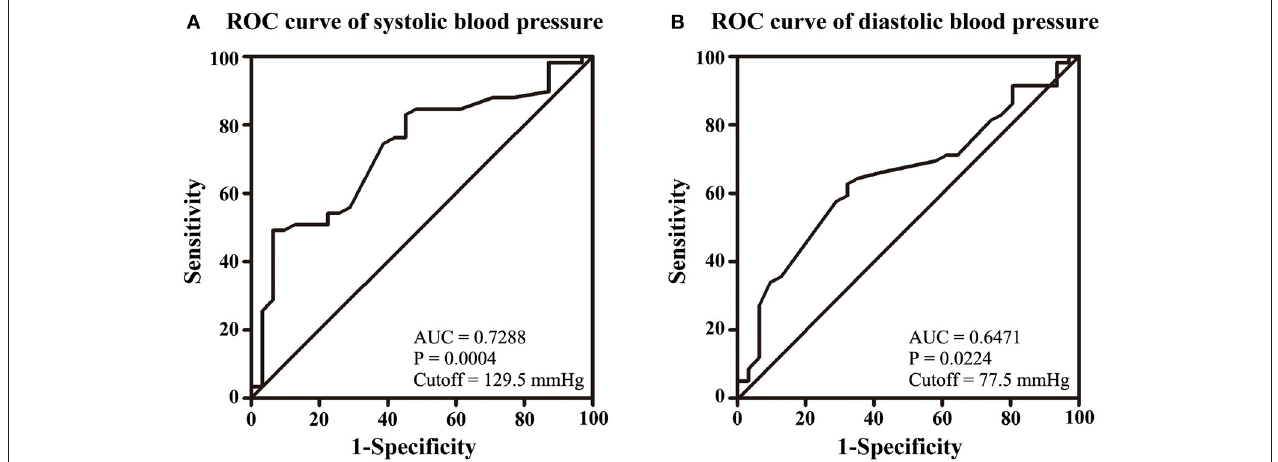
FIGURE 2 | Volumes of 129.5 mmHg of SBP (A) and 77.5 mmHg of DBP (B) were identified as cutoff values for IH.